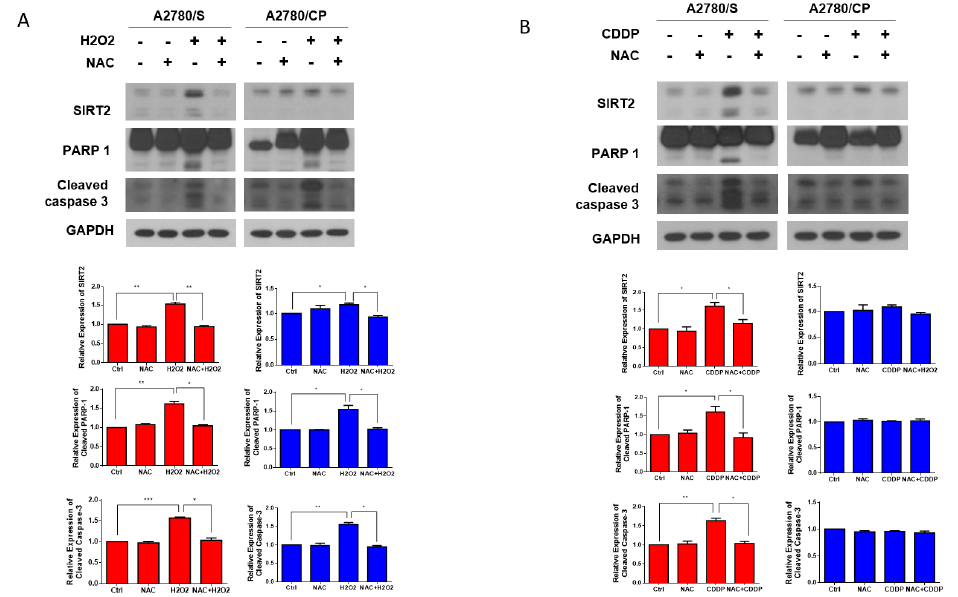
Figure 5. The A2780/S and A2780/CP cells were pretreated with NAC (5 mM) for 1 h, followed by H 2 O 2 (10 μ M) for 48 h. SIRT2 and apoptosis-related proteins were detected by Western blotting ( A ). The A2780/S and A2780/CP cells were pretreated with NAC (5 mM) for 1 h, followed by cisplatin (2 μ M) for 48 h. SIRT2 and apoptosis-related proteins were detected by Western blotting ( B ). Results are shown as mean ± SEM (* p ≤ 0.05, ** p ≤ 0.01, *** p ≤ 0.001).